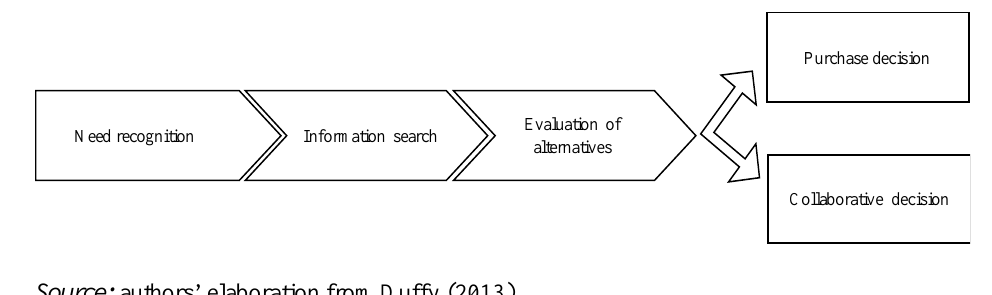
Figure 1: Buyer Process Toward Collaborative and Purchase